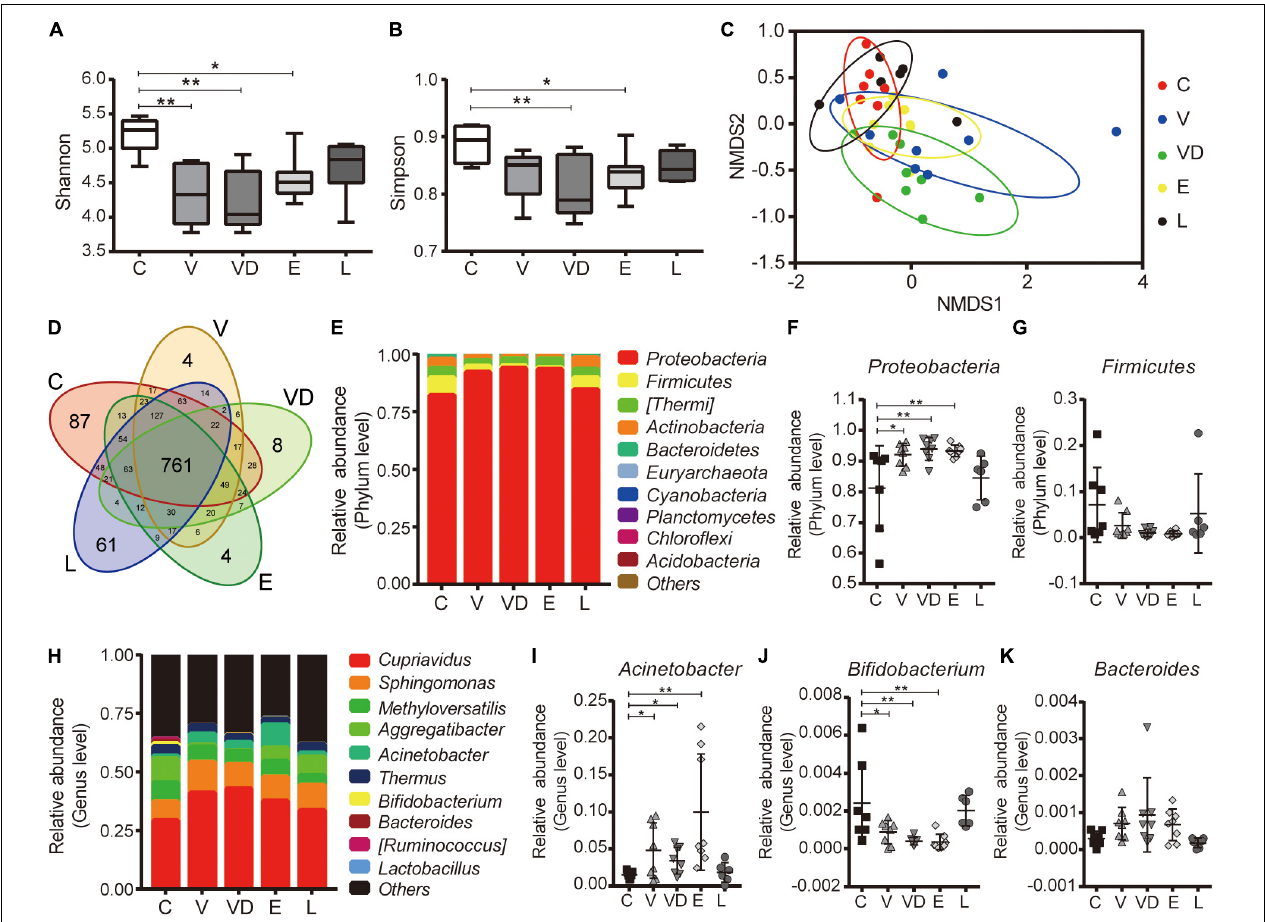
FIGURE 5 | The effect of the tested bacteria on the vaginal microbiota diversity of rats. (A) Chao1 index and (B) Shannon index among the indicated treatment groups. (C) NMDS analysis of the indicated treatment groups. (D) Venn diagram of the vaginal microbiota among the indicated treatment groups. (E) Microbial composition at the phylum level. Relative abundance of (F) Proteobacteria and (G) Firmicutes of vaginal bacterial communities in phylum level among the indicated treatment groups. (H) Microbial composition at the genus level. Relative abundance of (I) Acinetobacter , (J) Bifidobacterium , and (K) Bacteroides of vaginal bacterial communities at the genus level among the indicated treatment groups. The data represent means ± SD of six to eight animals. * P < 0.05, ** P < 0.01. SD, standard deviation; C, control; V, VNP20009; VD, VNP20009 DNase I; E, E. coli O157:H7; L, L. crispatus ; NMDS, non-metric multidimensional